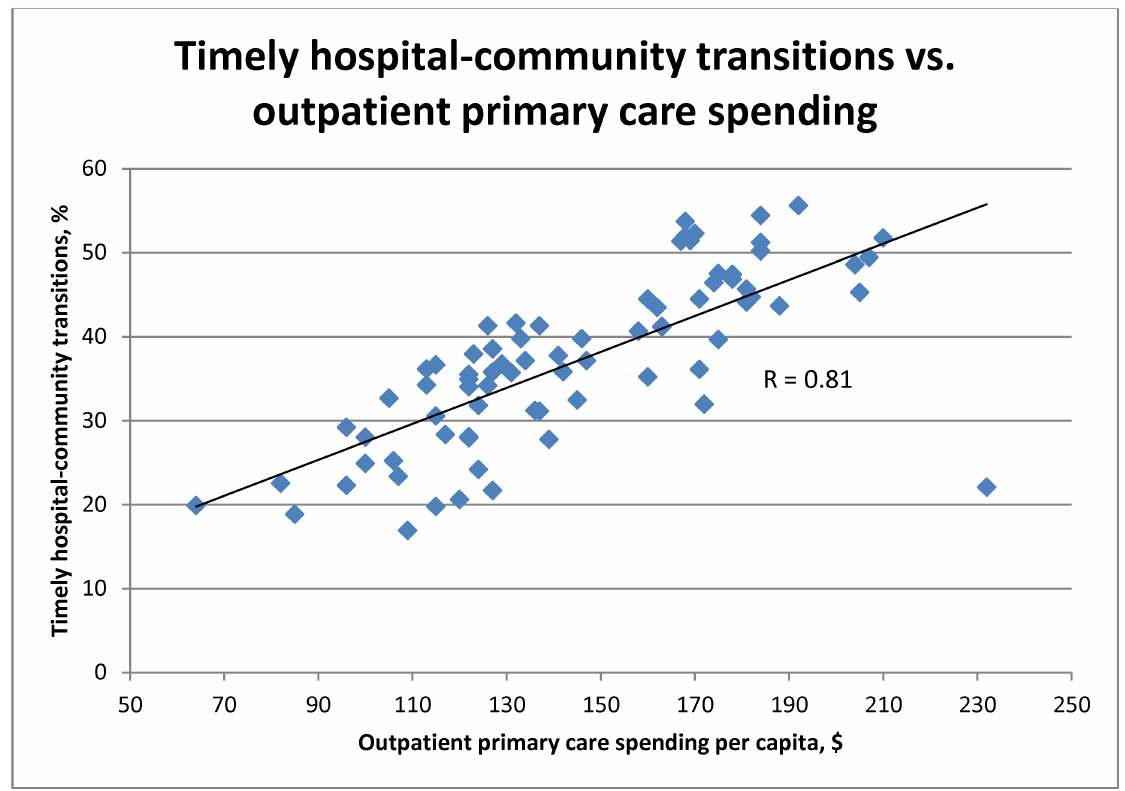
Fig 3. Timely hospital-community transitions (%) vs. outpatient primary care spending per capita. Quality indicators comprising timely hospital-community transitions were age-sex adjusted, except for office visit for a newborn within 7 days after hospital discharge. Outpatient primary care spending per capita was age-sex adjusted.